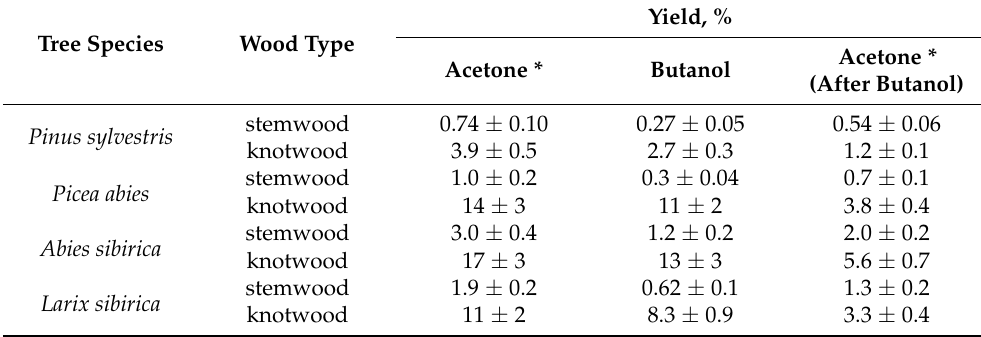
Table 2. Yield of stemwood and knotwood extractives (calculated on oven-dry wood material) obtained by the pressurized liquid extraction (100 ◦ C, 100 bar) with different